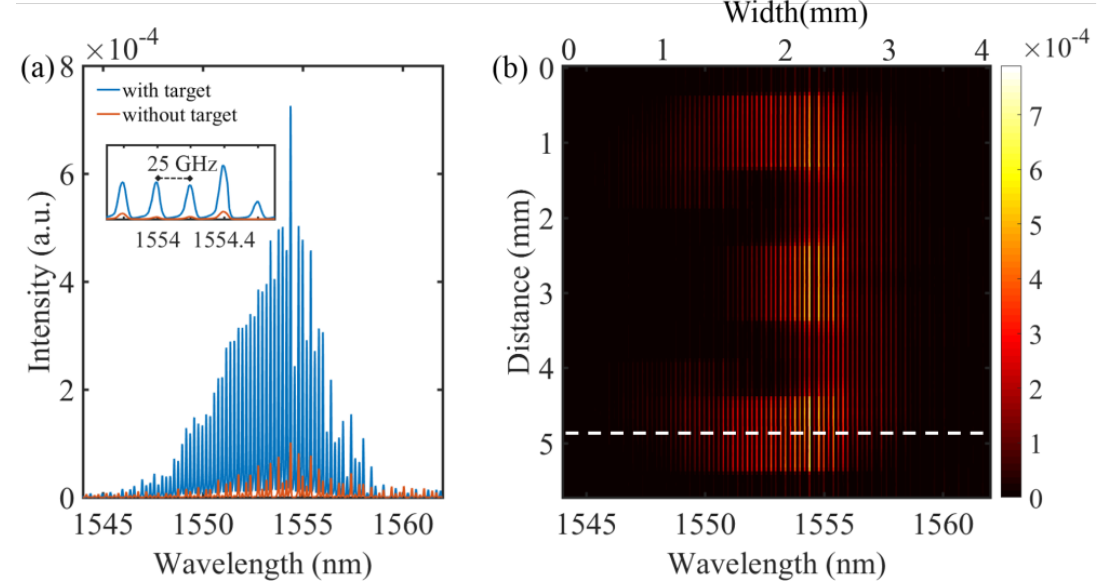
Figure 2. ( a ) A line spectrum obtained by the optical spectrum analyzer with and without the photon signal reflected from the target. Inset: zoom-in on the comb modes. ( b ) Two-dimensional spectrum encoding image of the target obtained by an optical spectrum analyzer. The blue spectrum in ( a ) was acquired at the position marked by the white dashed line in ( b ).